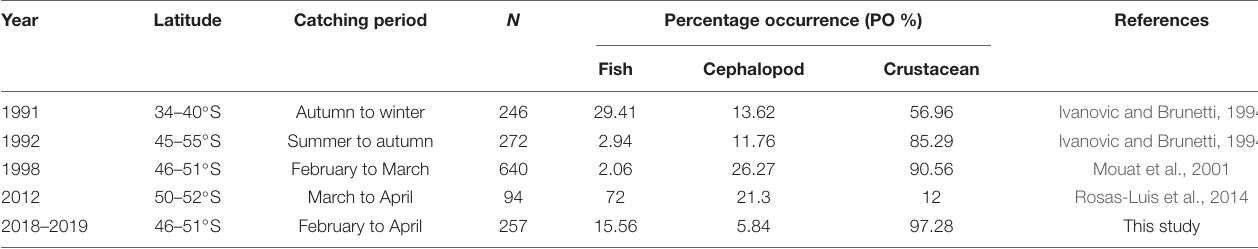
TABLE 4 | Comparison of dietary compositions of the Argentine shortfin squid Illex argentinus in the Southwest Atlantic over decades. Latitude